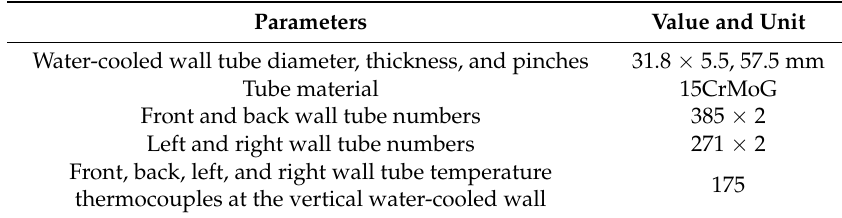
Table 2. The geometrical structure and parameters of the vertical water-cooled wall.